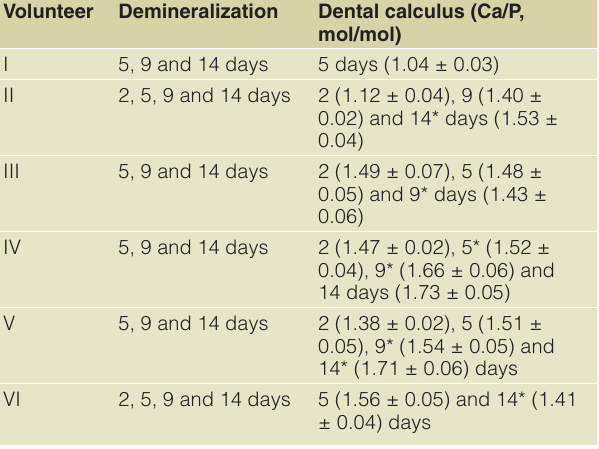
Table 1. Occurrence of demineralization and calculus deposits (with mean of 5 Ca/P ratios obtained by EDS-SEM). * Samples with 50% or more of their surfaces covered by